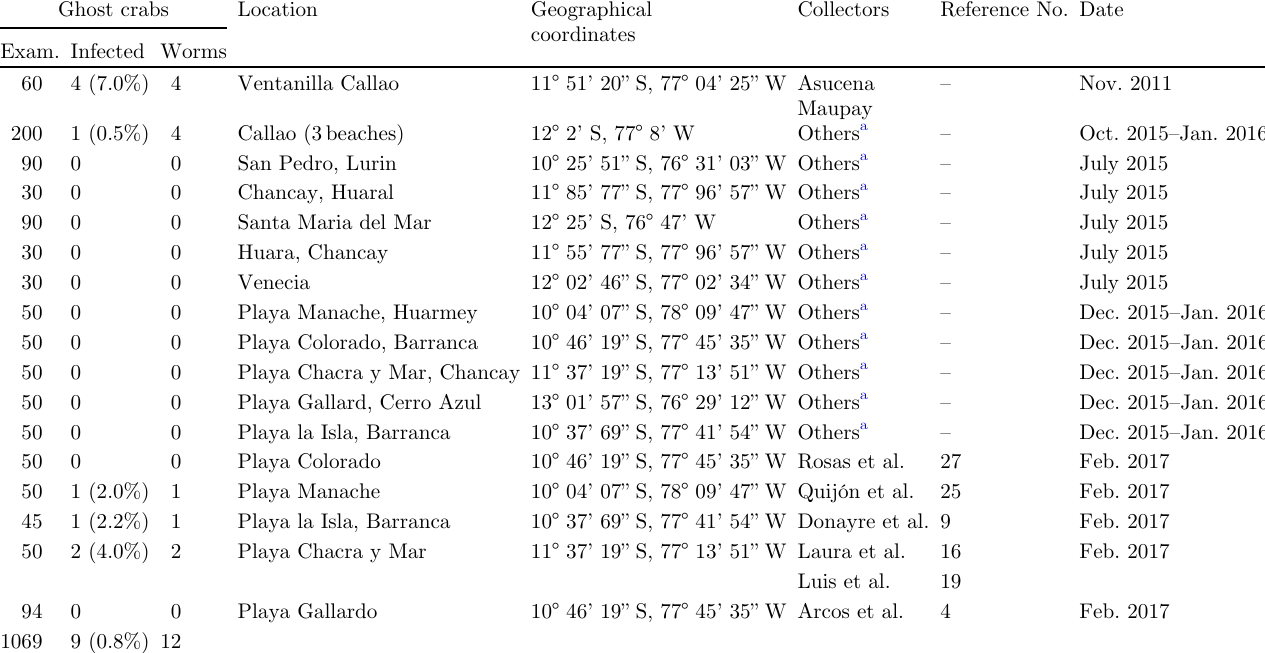
Table 1. Collections of specimens of Neoandracantha peruensis from the ghost crab Ocypode gaudichaudii from the Peruvian coast near Lima between 2011 and